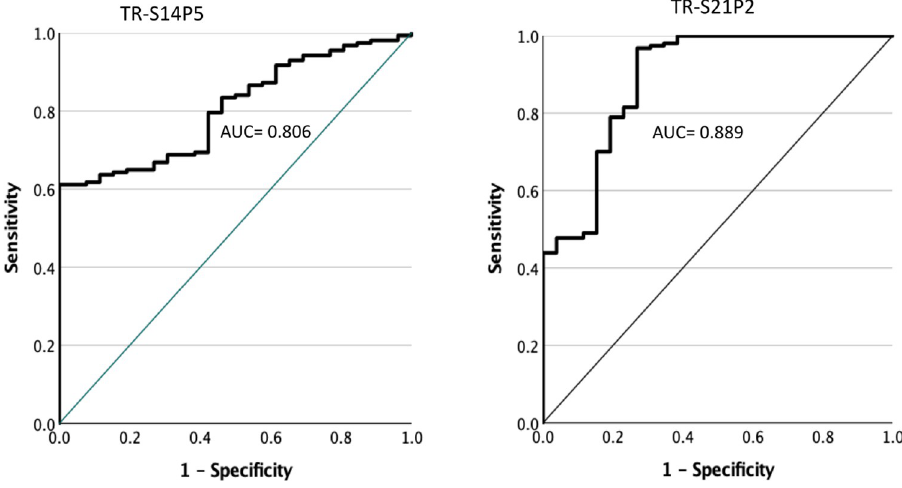
Fig 3. The accuracy of ELISA using either recombinant TR-S14P5 or TR-S21P2 as the coating antigen in discriminating positive from negative COVID-19 sera. The area under the curve (AUC) measures discriminating power. Diagnostic tests with an AUC of 0.8–0.9 are considered to have excellent discriminating power.